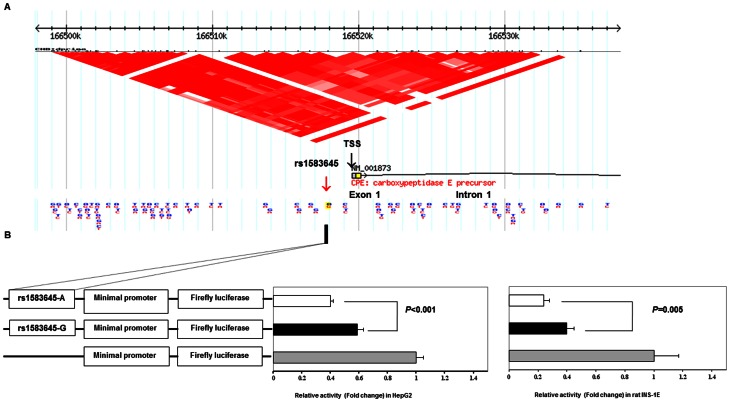
Effect of rs1583645 [G/A] polymorphism on luciferase activity assays.(A) Upstream region of transcription start site (TSS as indicated by the black arrow), first exon and part of intron 1 of CPE (NCBI Build 36.1, CHR4:166,496,501–166,536,501). The LD structure of CPE SNPs within this region was shown by D' using the Chinese HapMap data. The red arrow indicated the location of rs1583645. (B) CPE-[G/A] constructs consisting of 449 bp of CPE rs1583645 region and pGL4.23 firefly luciferase reporter vectors were transfected into HepG2 (left panel) and rat INS-1E cells (right panel) together with Renilla luciferase reporter vectors. Measurement of the firefly luciferase activity of CPE-[G/A] constructs was normalized relative to the activity of the Renilla luciferase vectors. Data were shown as mean±SEM of at least three independent experiments in triplicate set up. The constructs of CPE-G showed 50% and 66.7% increased transcriptional activity in HepG2 and rat INS-1E cells respectively when compared to the constructs of CPE-A (P<0.001 and P = 0.005 respectively by Mann-Whitney U-test).